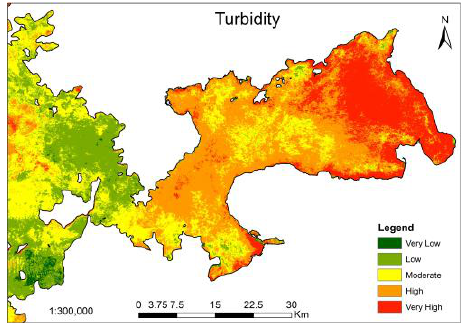
Figure 9: Shows turbidity levels in Lake Victoria The total suspended sediments show high levels in the deep areas of the lake, where the water is still, however the shallow ends of Winum Gulf, depicts a moderate value of suspended sediment due to the flowing water towards the deep ends. This is evidence of availability of undissolved particles in Lake Victoria’s waters.